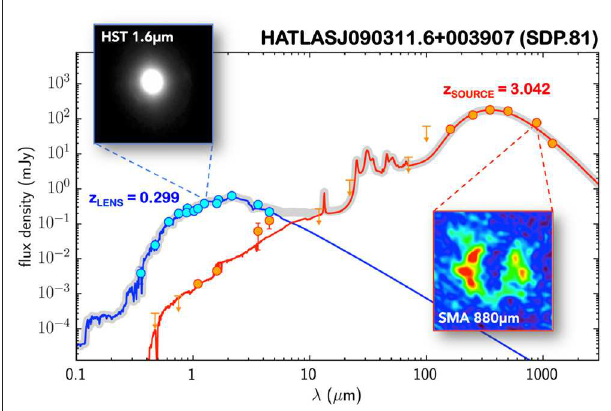
FIGURE 5 | SEDs of the strongly lensed galaxy SDP81 at 3.042 detected by the Herschel Astrophysical Terahertz Large Area Survey (H-ATLAS; Eales et al., 2010) and imaged with the Sub-Millimeter Array (SMA) at 880 µ m (Negrello et al., 2010) and of the foreground lens at z = 0.299 imaged with the Wide Field Camera3 (WFC3) on the Hubble Space Telescope (HST; Negrello et al., 2014). As is generally the case, the lens is a spheroidal galaxy in passive evolution, hence very faint at sub-mm wavelengths; indeed it is essentially invisible in the SMA image. The lensed source is dust-enshrouded, hence bright in the sub-mm but very faint in the optical and essentially invisible in the WFC3/HST image.